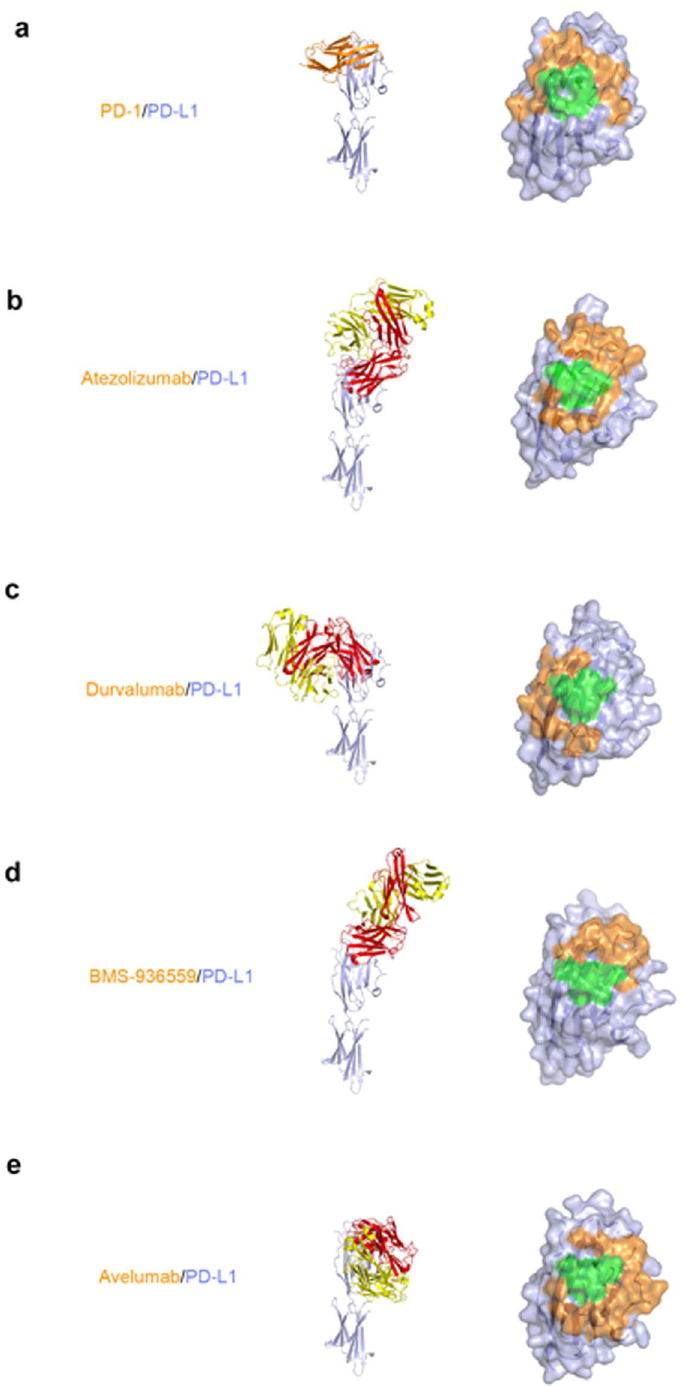
Figure 5. Comparison of the PD-L1 interactions with the receptor PD-1 and anti-PD-L1 antibodies. ( a ) Structure of PD-L1 (pale blue) in complex with PD-1 (orange) and the PD-1 binding site (orange) on the surface of the IgSF V-set domain of PD-L1. ( b ) Structure of PD-L1 in complex with atezolizumab Fab and its epitope on the surface of the IgSF V-set domain of PD-L1. ( c ) Structure of PD-L1 in complex with durvalumab Fab and its epitope on the surface of the IgSF V-set domain of PD-L1. ( d ) Structure of PD-L1 in complex with BMS-963559 Fab and its epitope on the surface of the IgSF V-set domain of PD-L1. ( e ) Structure of PD-L1 in complex with avelumab Fab and its epitope on the surface of the IgSF V-set domain of PD-L1. In ( a – e ) the IgSF V-set and IgSF C-set domains of PD-L1 are displayed in the same orientation, and the antibody heavy and light chains and their epitopes are colored red, yellow, and orange, respectively. The shared regions on the epitopes of the four antibodies and the PD-1 binding site are colored